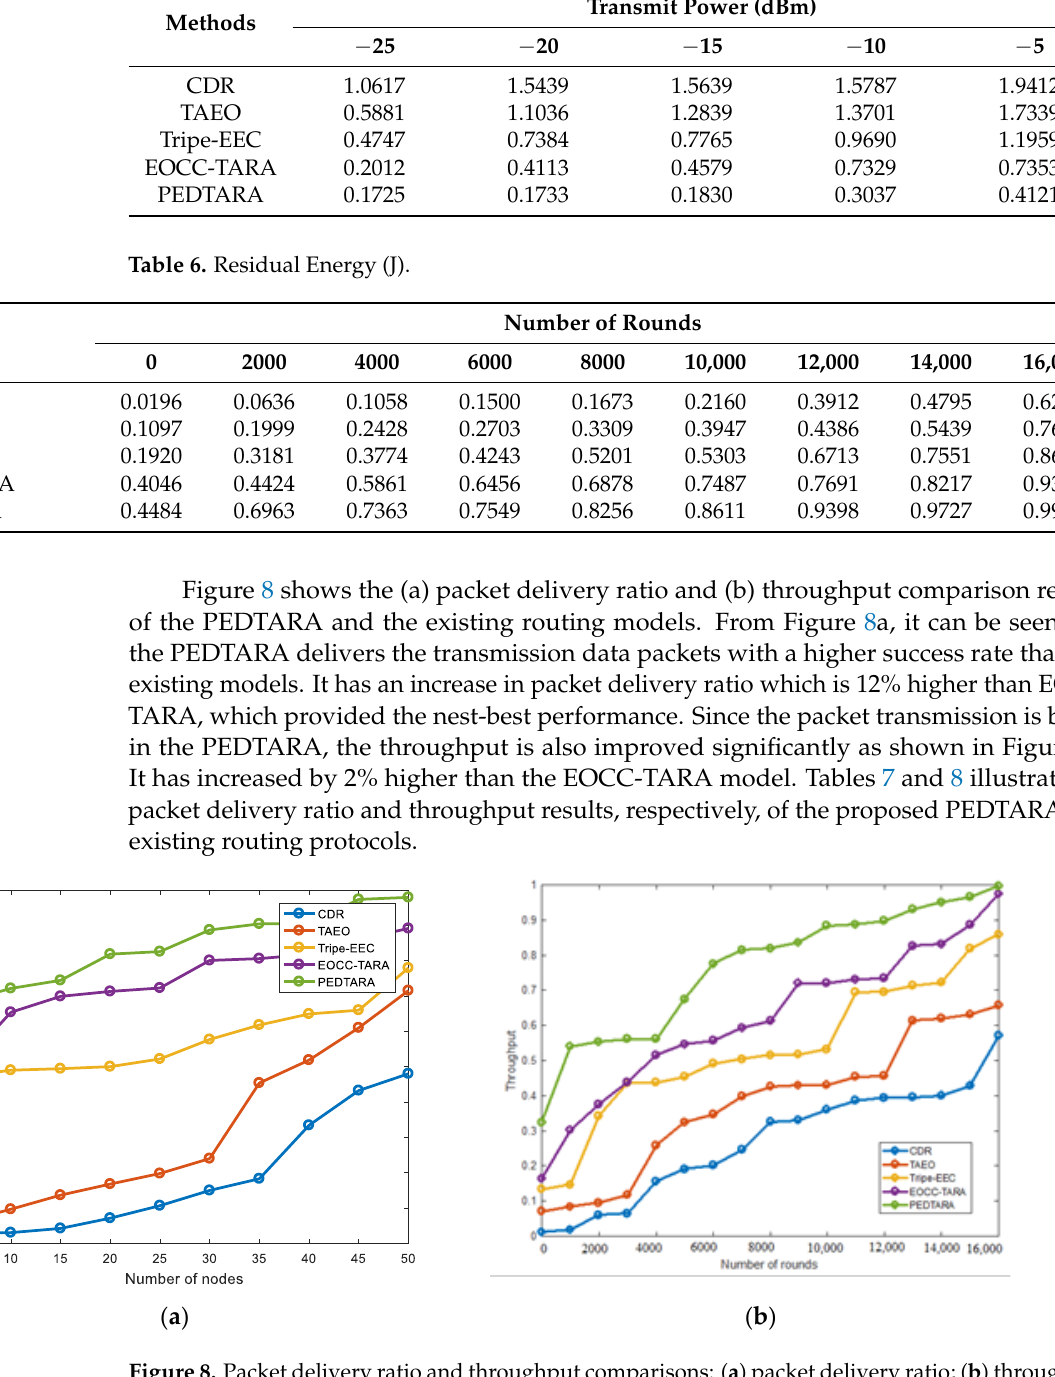
Table 8. Throughput.